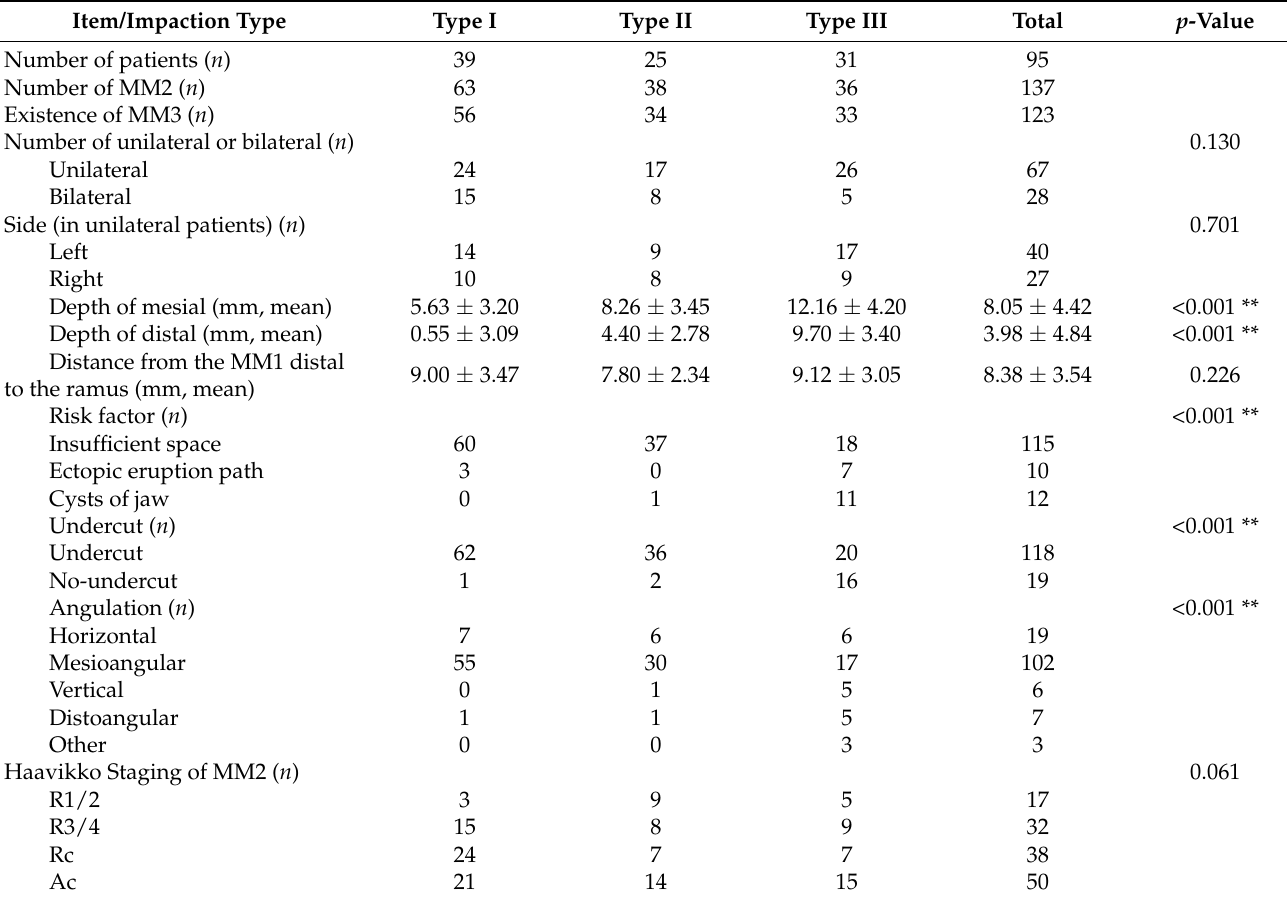
Table 3. Measurements between types based on